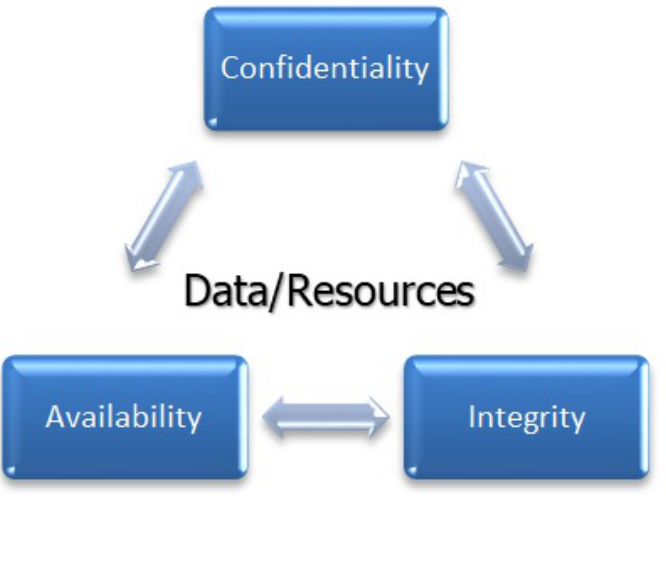
Figure 1. The CIA